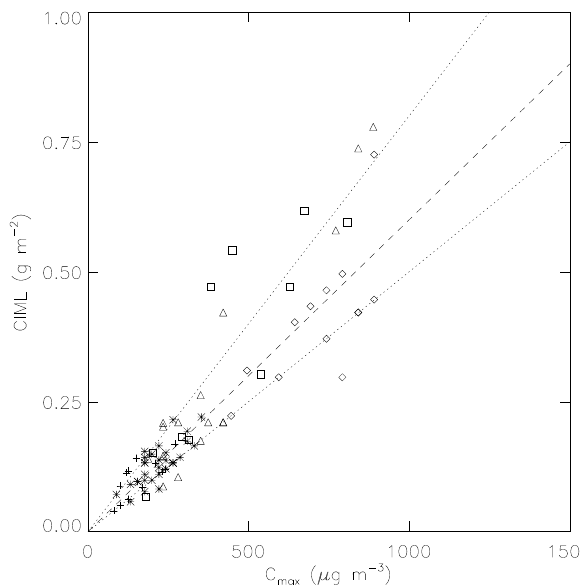
Fig. 3. Comparison between the column integrated mass load (CIML) and the maximum concentration ( C max for lidar observations. The dashed line corresponds to an effective depth for the ash layers of 600m, the dotted lines are for effective depths of 500 m and 800 m. The symbols show results for different flights. 4 th (crosses) ; 5 th May (stars) ; 14 th May (diamonds); 16 th May (triangles) and 17 th May (squares). Table 1. Estimates of distal fine ash fraction, α f (%).